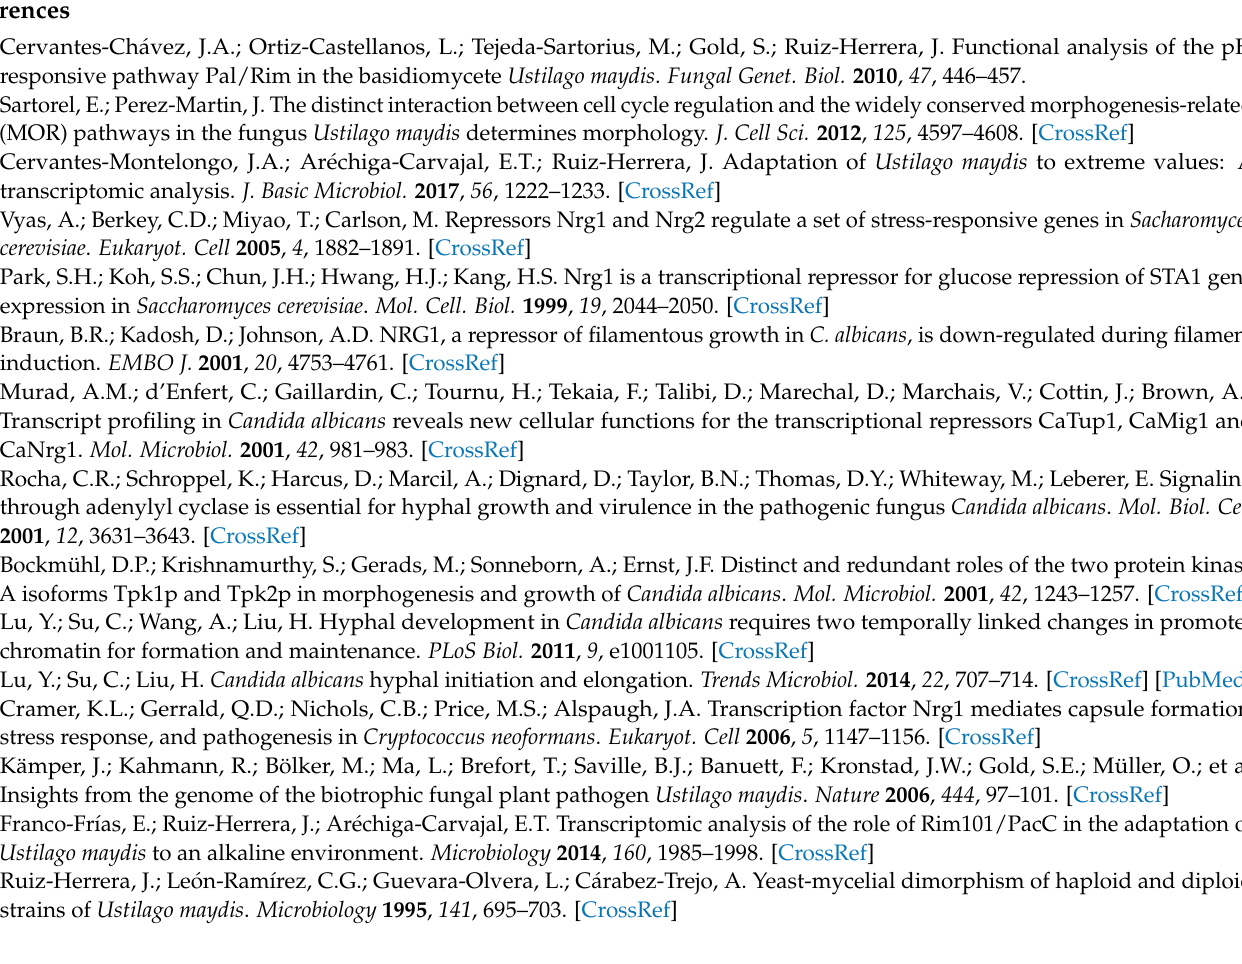
NRG1 mutation in U. maydis , Table S2: List of oligonucleotides used for RT_qPCR, Table S3: DEGs at pH4 for NRG1 strain, Table S4: Transcription analysis RT_qPCR, Table S5: Upregulated and down regulated genes by NRG1 , Table S6: NRG